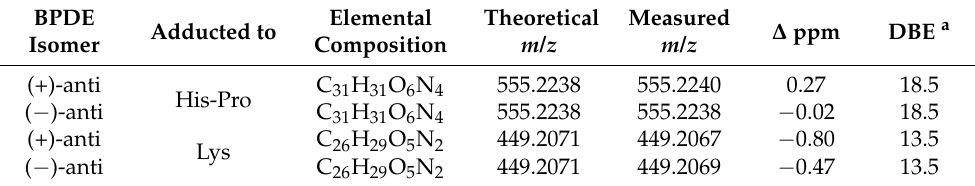
Table 1. Identification of BPDE adducts in in vitro alkylated SA based on elemental composition of the [M + H] + ions according to accurate m/z measurements. BPDE